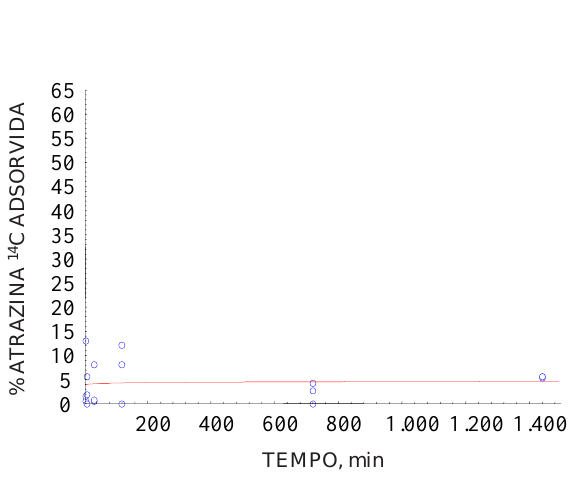
Figura 5. Percentagem de atrazina- 14 C adsorvida do total adicionado em materiais de Latossolo Roxo. Solo com matéria orgânica removida (a) e argila com matéria orgânica removida (b).